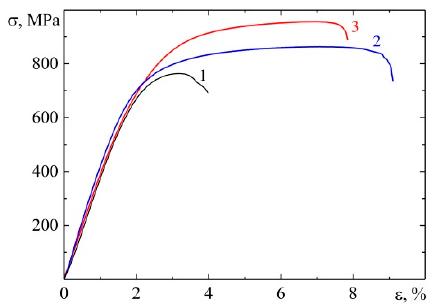
Figure 15. Tensile engineering stress–strain curves for as-built (curve 1), mechanically polished (curve 2), and irradiated Ti–6Al–4V samples (curve 3).